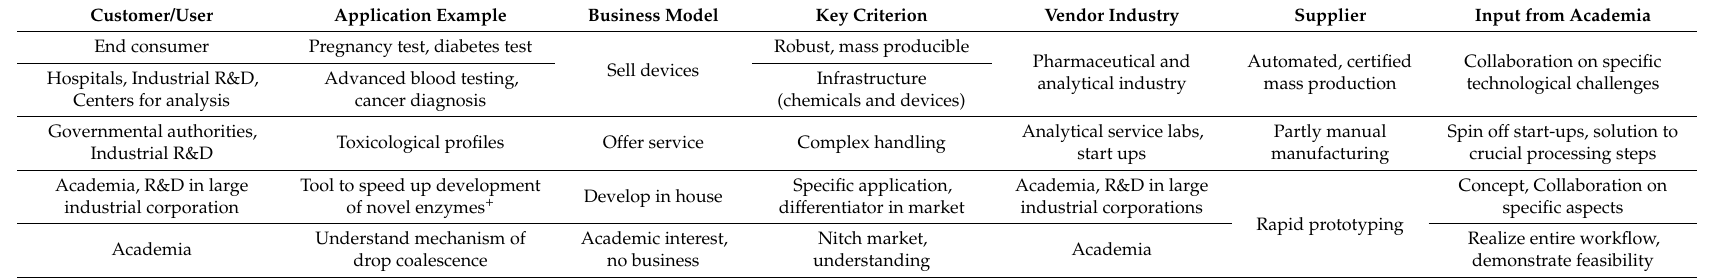
Table 1. Overview of the stakeholders and their roles and interactions in bringing microfluidic screening technologies to the